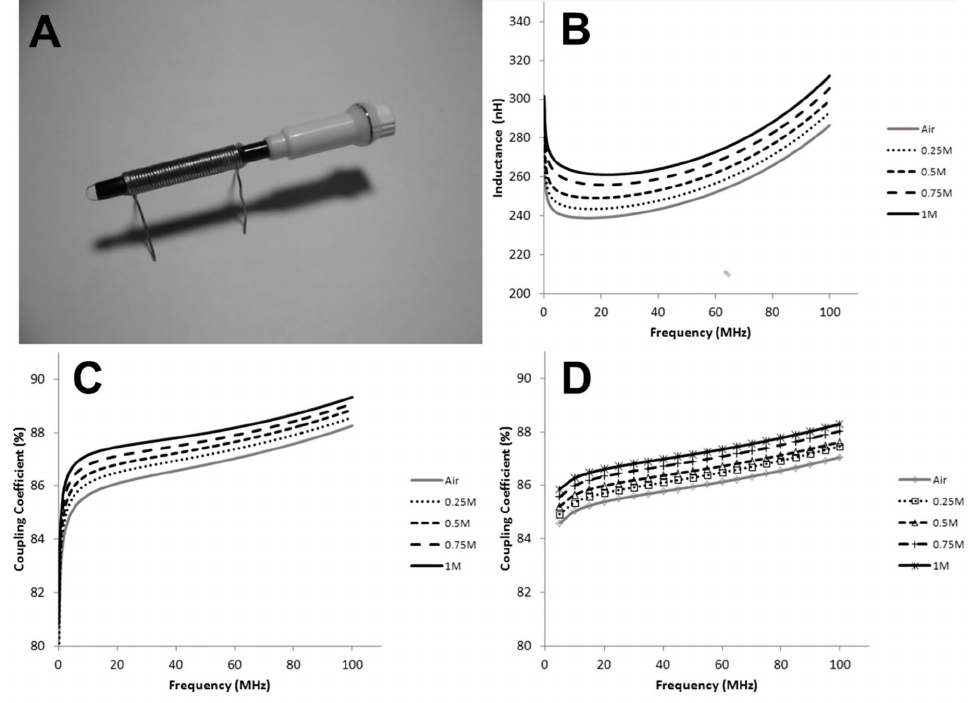
Figure 10. ( A ) Transformer on a capillary using oil − based ION FNs; ( B ) the inductances of trans- former coils with different types of magnetic cores; the coupling coefficients according to ( C ) measured data and ( D ) simulated data of on − chip transformers with different magnetic cores (air and Fe 3 O 4 NP − based FNs of 0.25, 0.5, 0.75, and 1 M). Reprinted with permission from Ref. [106]. Copyright 2011, Springer